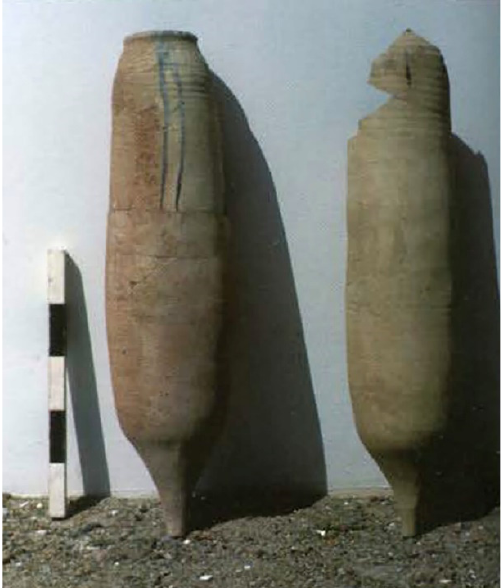
Figure 6. The two torpedo jars DA7383 and DA7384 following discovery on Masirah Island (after Weisgerber and Al-Shanfari 2013, Figure 174).